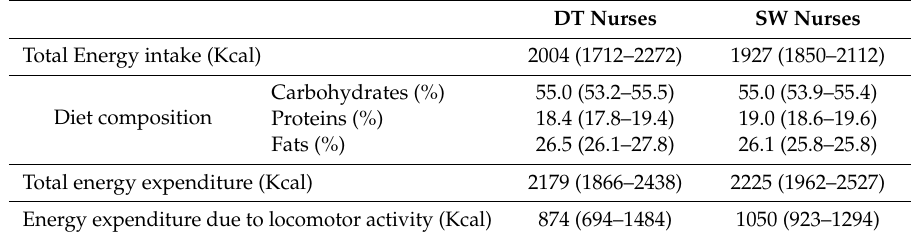
Table 3. Energy intake, diet composition, and total energy expenditure of daytime (DT) and shift-working (SW) nurses. Results are expressed as median (25th–75th percentile).